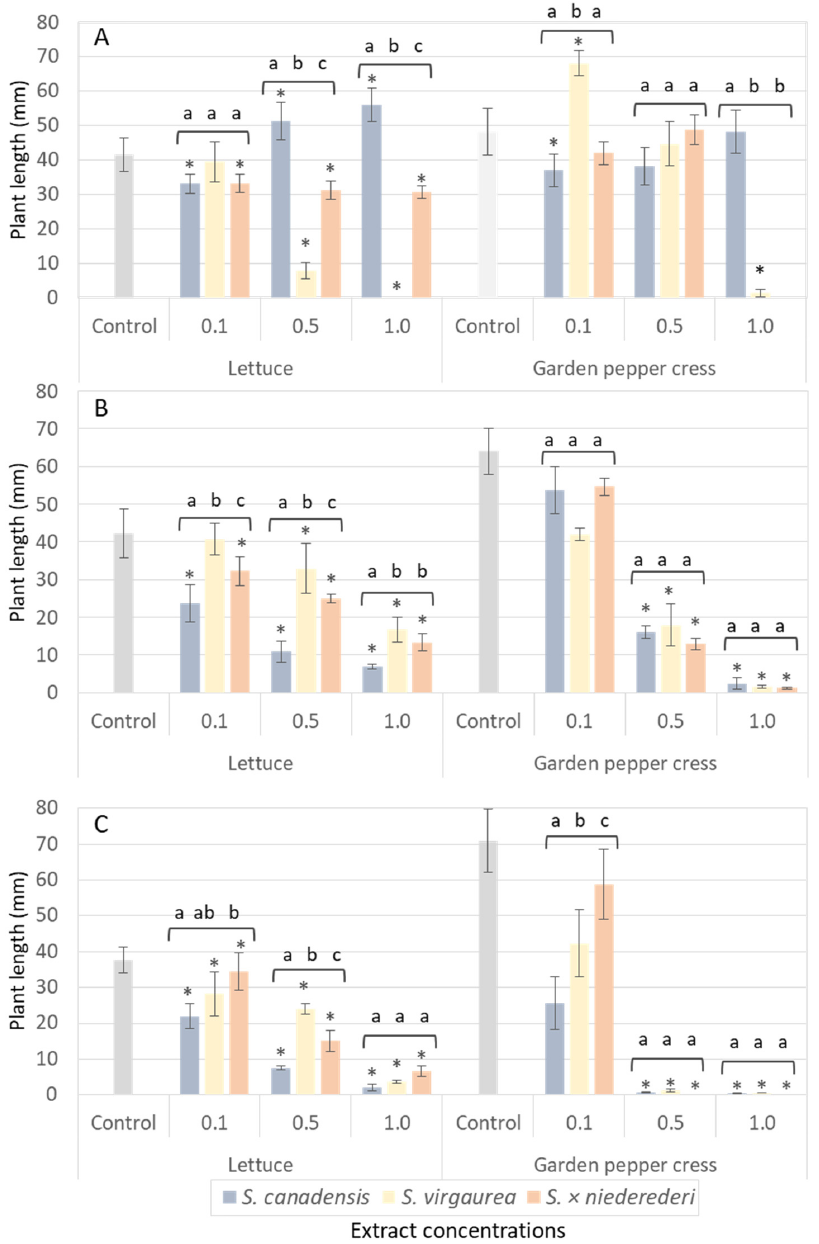
Figure 4. Effect of aqueous extracts from roots ( A ), leaves ( B ) and inflorescences ( C ) of S. canadensis , S. virgaurea and S. × niederederi on the seed germination and growth of lettuce and garden pepper cress at 0.1, 0.5 and 1.0 relative concentration (one-way ANOVA test, df = 3, p < 0.05). Data are presented as mean of treatments (n = 60) ± SD (bars); asterix (*) indicates statistically significant differences compared to the control; letters (a, b and c) denote statistically significant differences between various species (Tukey’s test, p < 0.05).